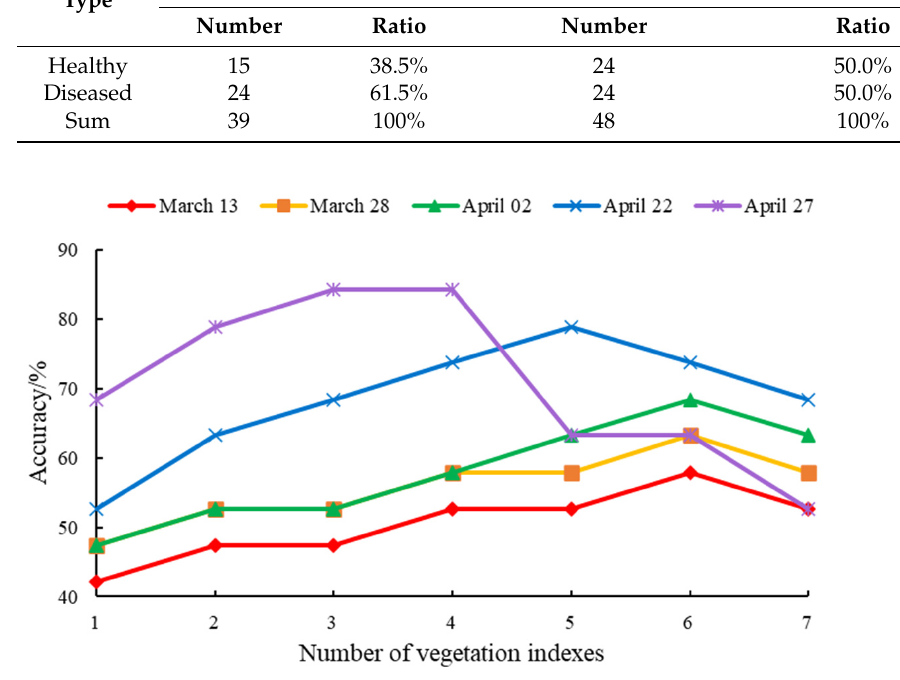
Figure 5. Model accuracy changes with an increasing number of considered vegetation indices at five dates, calculated by the sequential forward selection (SFS) algorithm. After removing the similarity, each vegetation indices was added in descending order of the weight coefficients. Table 5. The optimal vegetation indice combinations at five dates. Each row represents the optimal vegetation indice combinations on the corresponding date.